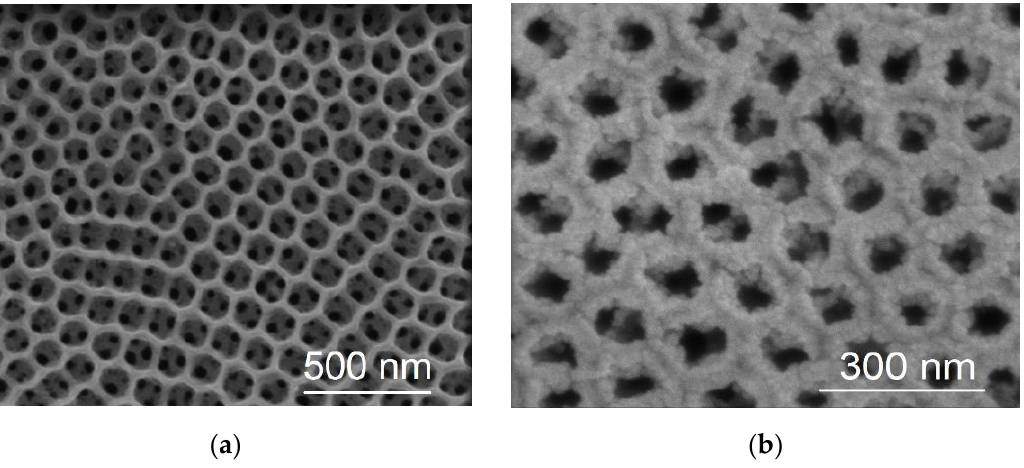
Figure 1. Top-view SEM micrographs of ( a ) bTNTs and ( b ) Pt/bTNTs. (Figure S1: X-ray diffractogram of Pt/bTNT that includes peaks from TiO2 in anatase structure, hexagonal Ti and cubic Pt according to the corresonding ICDD-JCPD files. As it can be observed, the Ti and Pt characteristic peaks are present in the spectrum of Pt/bTNT).